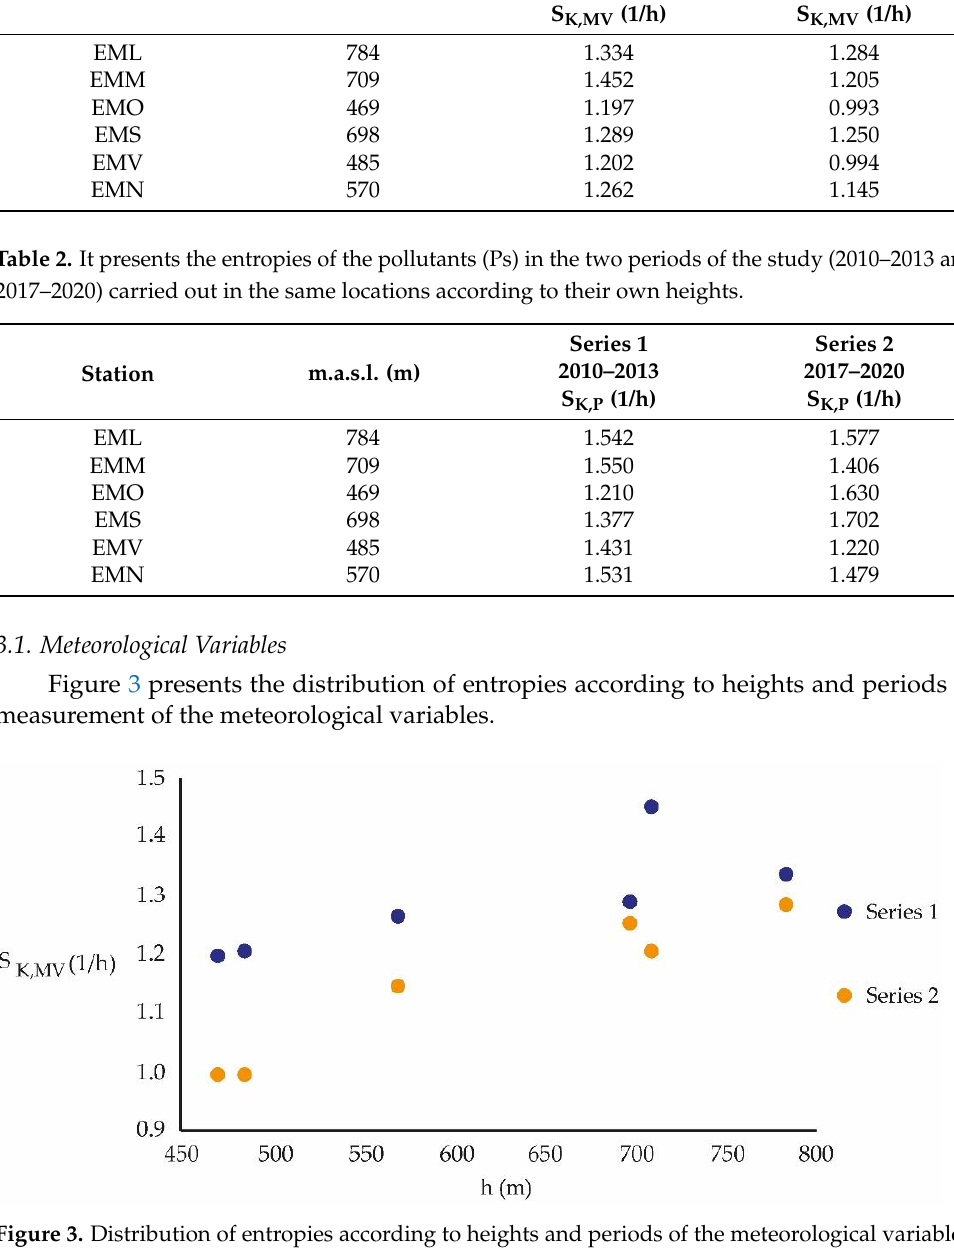
Figure 4. Distribution of entropies according to heights and periods of the pollutants. 3.3. Relationship between S K,MV and S K,P It can be establish a relationship between C K = S K,MV /S K,P = (∑ S K.MV,i / ∑ S K.P,i ) COMMUNES and the height of the different monitoring stations of meteorological and pollutant varia- bles and, in addition, of the measurement periods, what appears in Table 3 and is plotted in Figure 5.